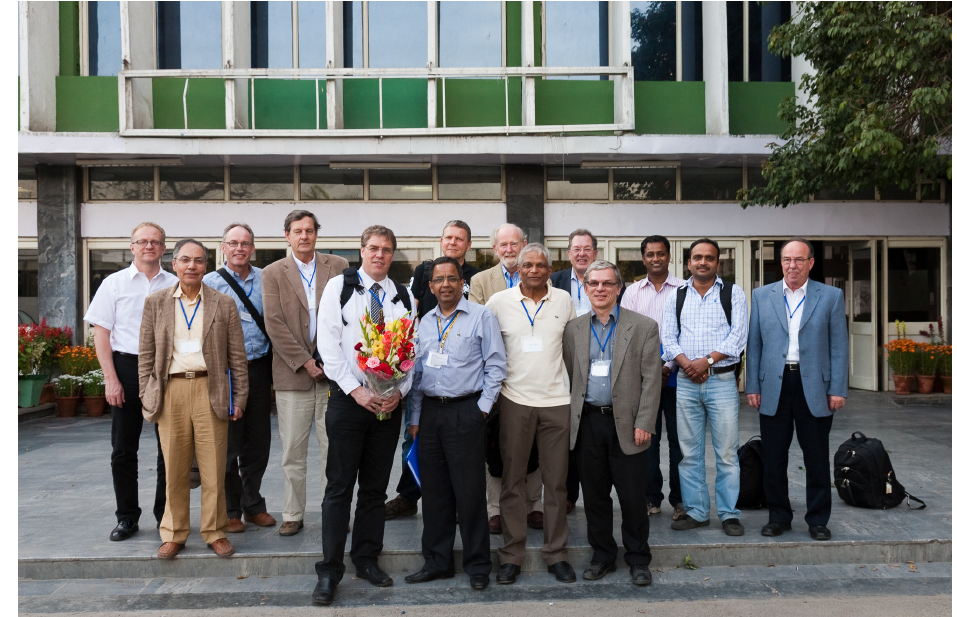
Table 1. Scientific complement symposia and Bob Sim’s role therein.